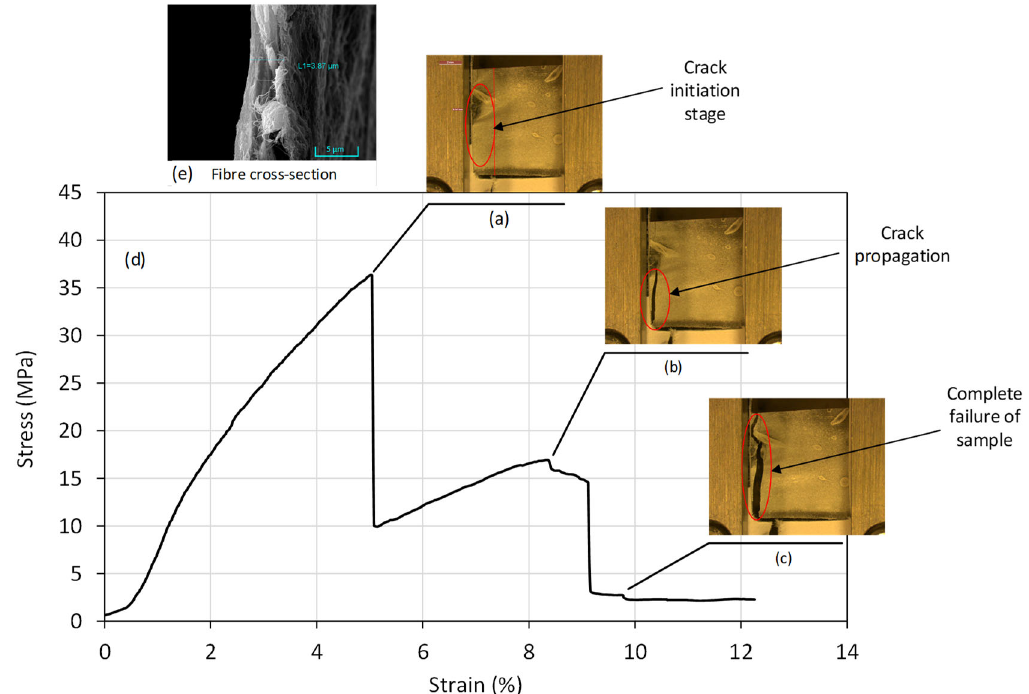
Figure 10. Mechanical testing of electrospun alginate/OEO fibre mesh: real ‐ time close ‐ up photos of sample ( a ) fibre mesh crack initiation, ( b ) crack propagation, and ( c ) complete failure of sample; ( d ) the stress–strain plot; ( e ) typical fibre cross ‐ section.